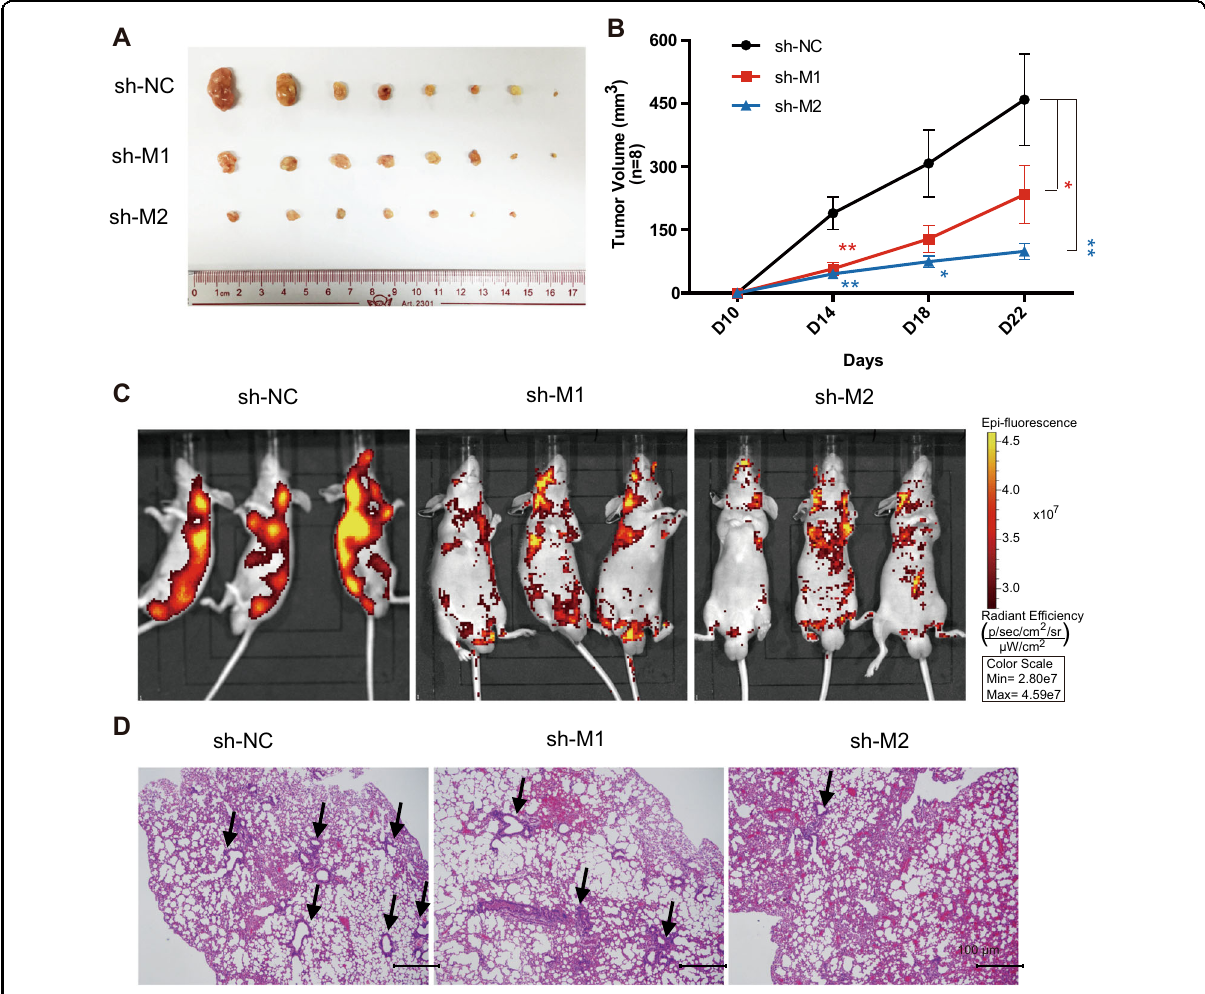
Fig. 5 MALAT1 promotes HCC tumor growth and metastasis in vivo. A Subcutaneous tumor formation in male BALB/c-nu mice. shMALAT1-1 or shMALAT1-2 Bel7402 stable cells were injected subcutaneous on the right side of mice, while the same number of corresponding control cells were injected on the left side of the same mice. After 4 weeks, the mice were dissected, and the tumors grown under the skin were removed, measured, and photographed. B The tumor volumes were measured on day 10, 14, 18, and 22 after subcutaneous injection. n = 8/group. C In vivo metastasis assay of Bel7402 cells with MALAT1 downregulation was performed by tail intravenous injection. Representative images of mice with the scramble control (shNC), shMALAT1-1, or shMALAT1-2 knockdown constructs were taken by the in vivo animal imaging system. The bioluminescence signals indicated the location of cancer cells. D Mice after the bioluminescence signal detection were sacri fi ced and dissected. Organs were excised and the metastasis in lung was further investigated by immunohistochemistry analysis. Representative H&E staining images showing lung metastasis in control and shMALAT1 mice. Lesions in lung are indicated by black arrows. Scale bar represents 100 μ m. Quantitative data were represented as mean ± SD. * P < 0.05, ** P <